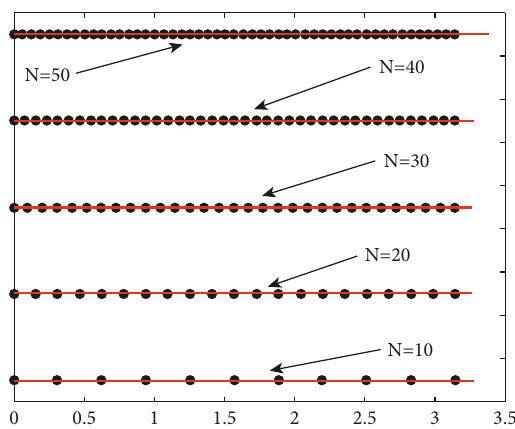
Figure 2: Node distribution of numerical for Example 1 with different values of N .